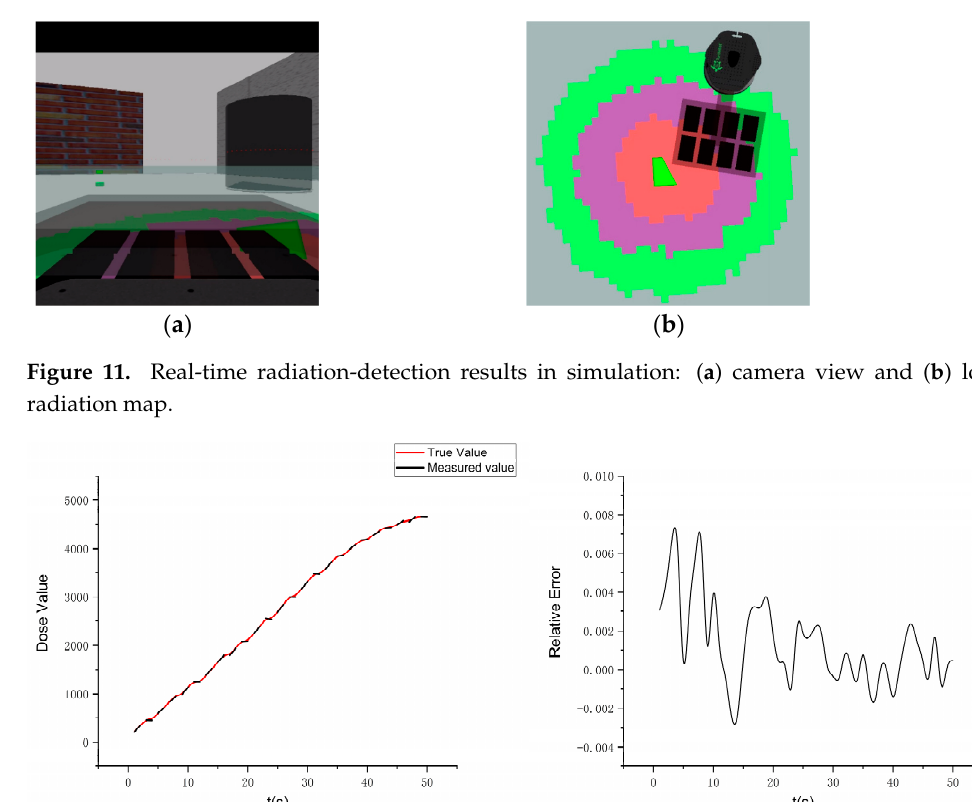
Figure 12. Analysis of radiation-detection data: ( a ) comparison of real radiation data with measured radiation data and ( b ) radiation-detection-data errors.